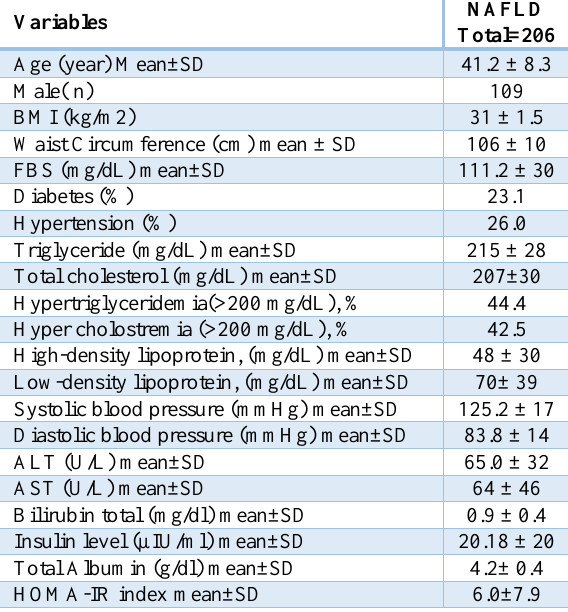
Table 1 . The Basic Characteristics of Patients With NAFLD